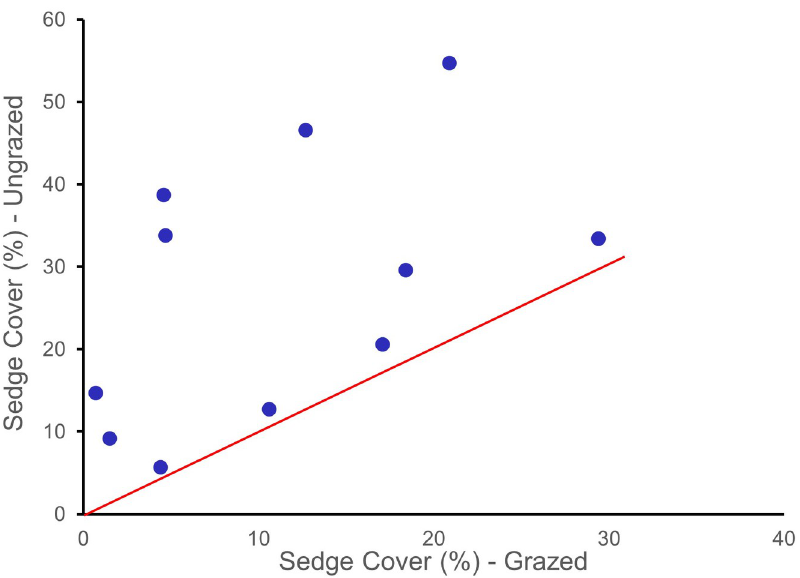
Fig 2. Comparison of sedge cover for 11 paired grazed and ungrazed riparian reaches in northeastern Oregon. If there was no change in the abundance of sedges between grazed and ungrazed areas the data points would be expected to fall on, or near the line. Data points above the line indicate a higher abundance of sedges in ungrazed areas compared to grazed reaches. The abundance of sedges in exclosures was significantly greater p = 0.004) than in grazed